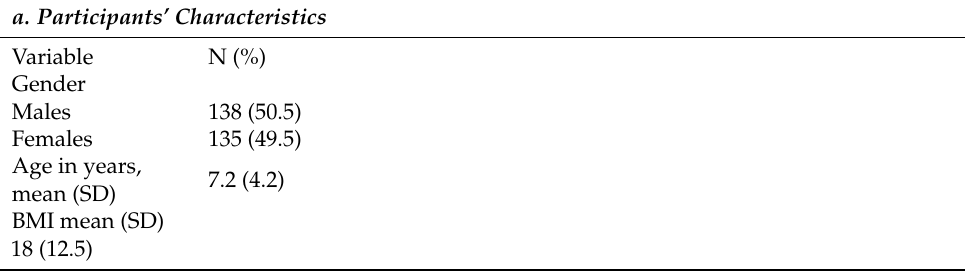
Table 1. (a) Participants’ characteristics, (b) information according to